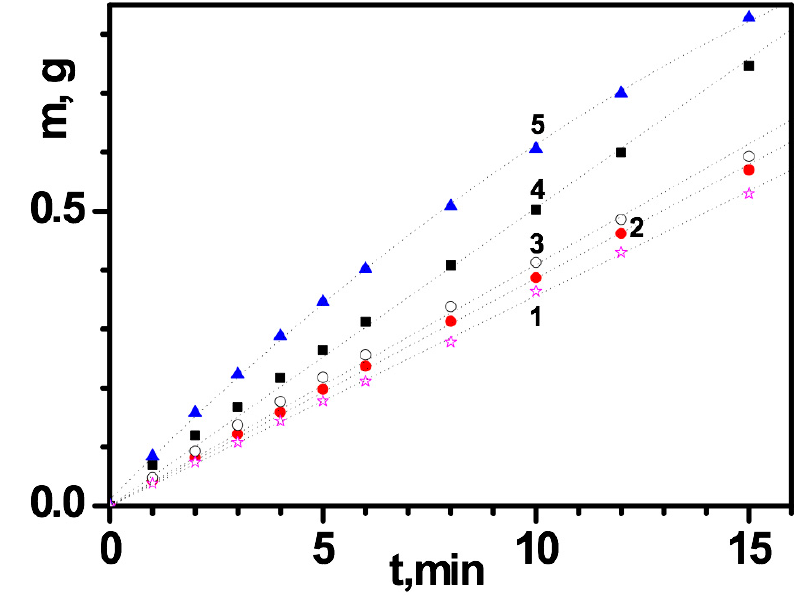
Figure 5. The weight loss of the sample as a function of time during free evaporation from the Petri dish with a diameter d = 9 cm for the system: ( 1 ) n-heptane–pure, ( 2 ) CDE:n-heptane, mass ratio 3:1, ( 3 ) FA:n-heptane, mass ratio 3:1, ( 4 ) PC:n-heptane, mass ratio 3:1, ( 5 ) EP:n-heptane, mass ratio 3:1. Temperature T = 22 °C, relative humidity H = 25%.